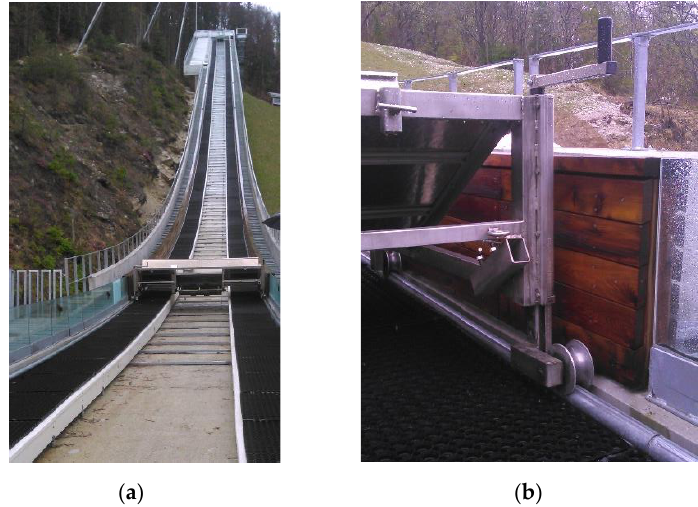
Figure 1. The device for making the snow profile (the trolley): ( a ) inrun of the Planica ski-flying hill; ( b ) installation of the trolley on the tube.